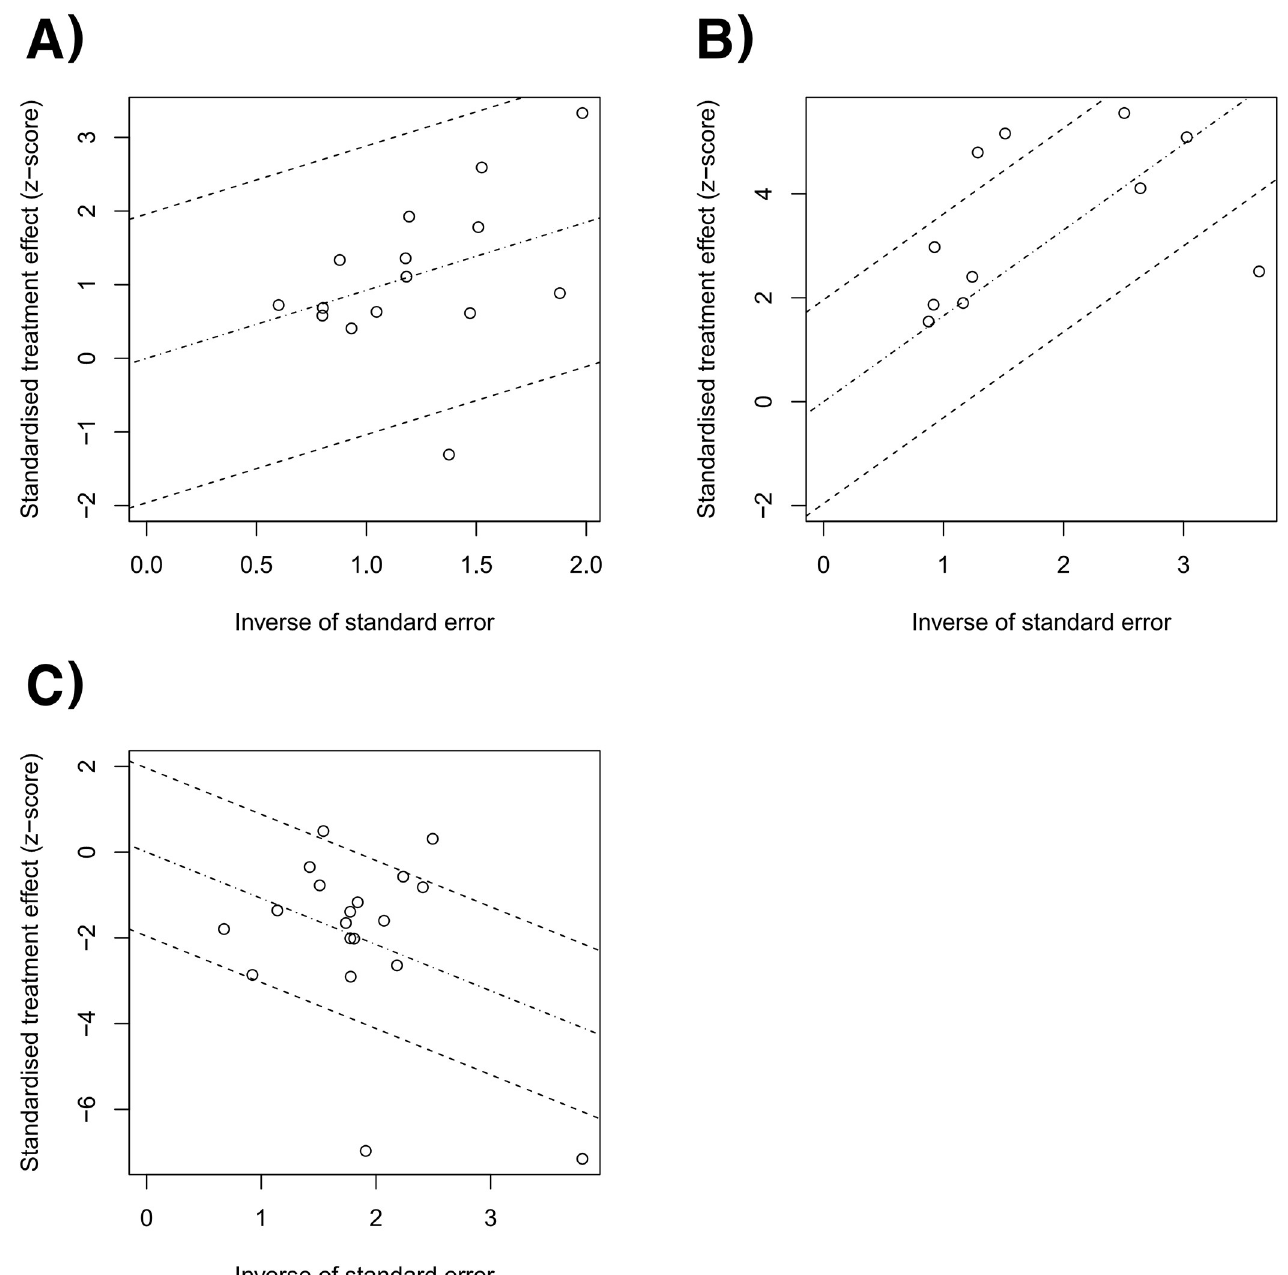
Fig 7. Radial plots of success rate between RIRS and PCNL (A), SWL and PCNL (B), and RIRS and SWL (C). Little heterogeneity was noted in radial plots.